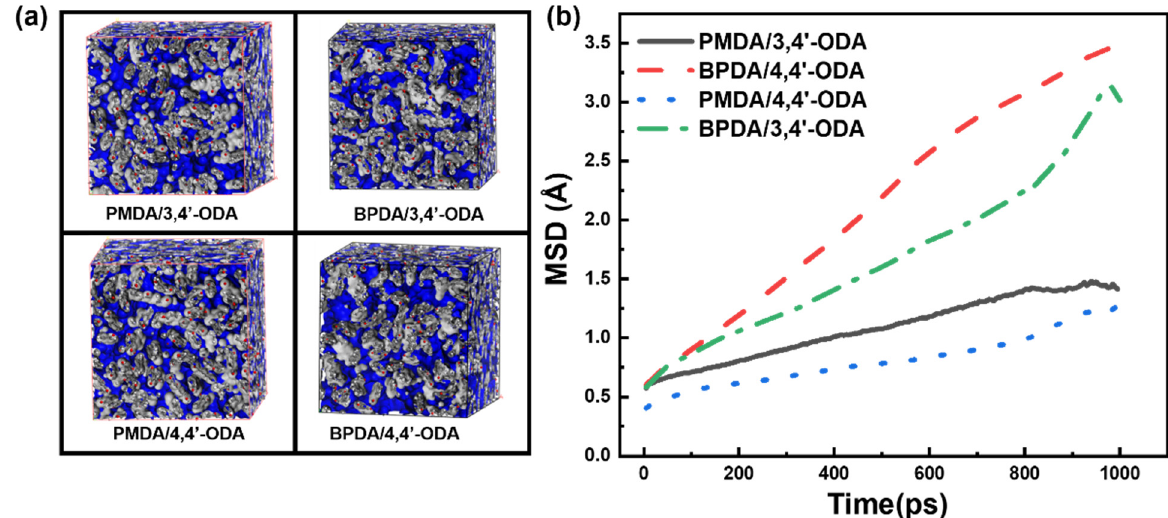
Figure 12. ( a ) The FFV of different PI models; ( b ) the MSD curves of different PI models.